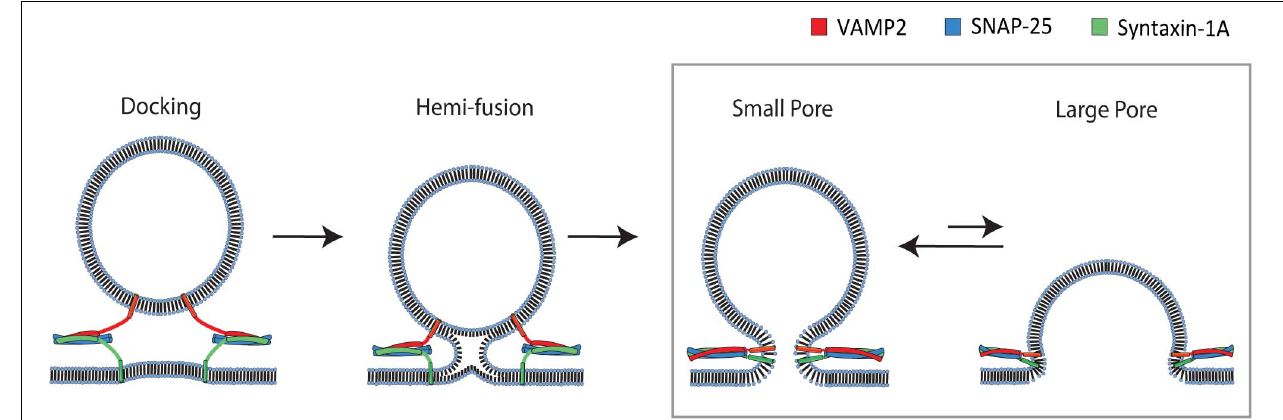
FIGURE 1 | Pathway of SNARE-mediated membrane fusion. The v-SNARE VAMP2 located on the incoming vesicle initiates binding to the t-SNAREs syntaxin-1A and SNAP-25 on the plasma membrane. The v-and t-SNAREs begin to zipper into a coiled-coil that docks the vesicle to the plasma membrane. Continued zippering drives the outer leaflets of the two membranes to merge into a hemifusion state. Complete zippering drives the merger of the inner leaflets of two bilayers, which creates a small fusion pore. The small pore expands to a large pore, resulting in complete merger of the vesicle to the plasma membrane. The box shows the transition to which our single vesicle fusion assay is designed to be